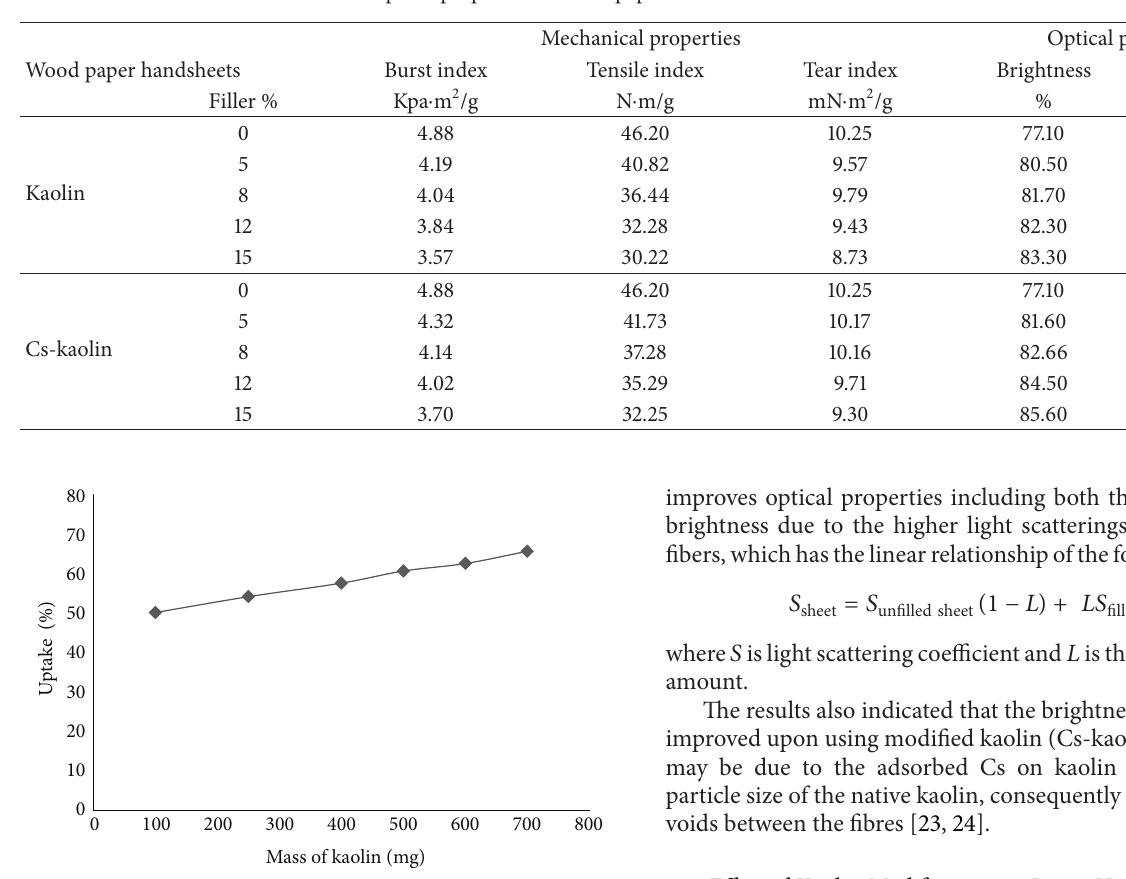
Figure 3: Variation of uptake percentage with kaolin mass for cesium sorption on kaolin. Operating conditions: 50 mL solution, [Cs + ] = 25 mg/L, pH = 6, and shaking time =